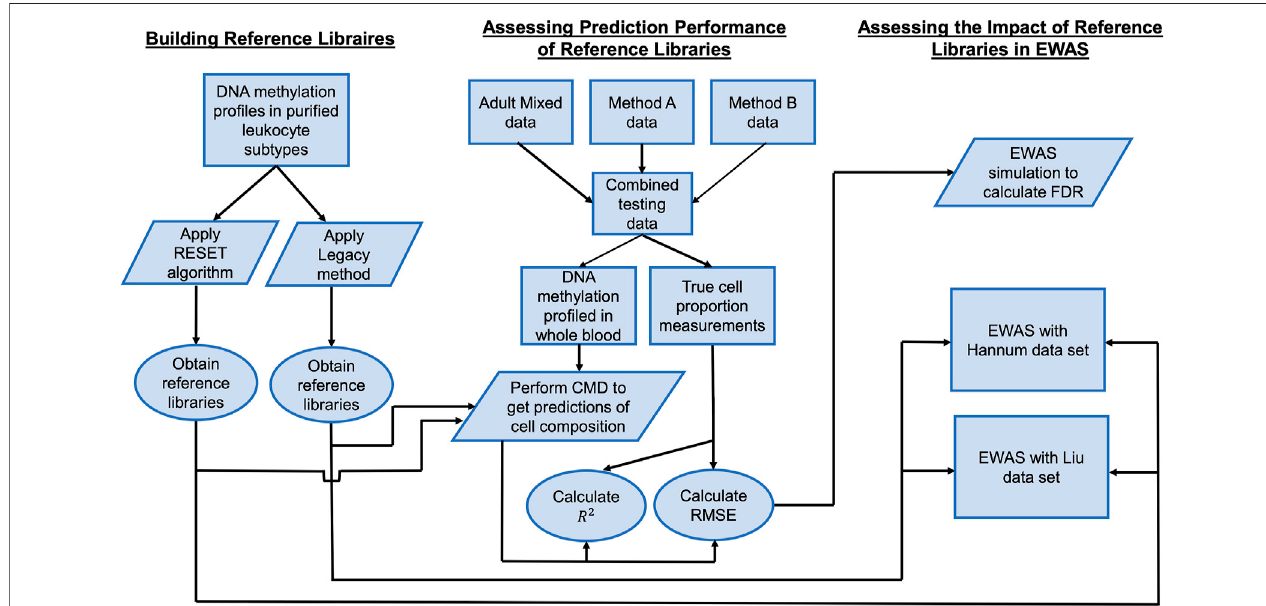
FIGURE 1 | Analytical work fl ow. A work fl ow for describing the data sets used and analyses that were